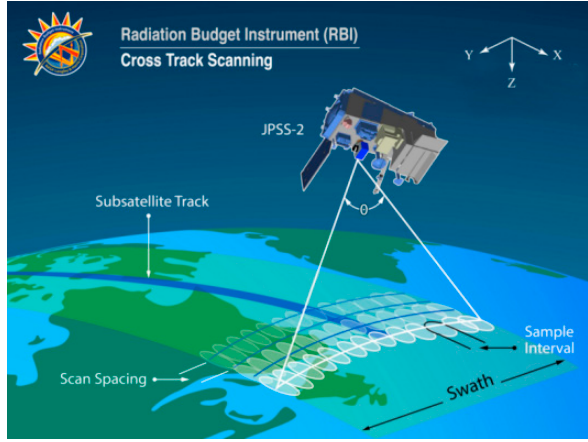
Figure 1. Radiation budget instrument (RBI) [3] scan pattern.